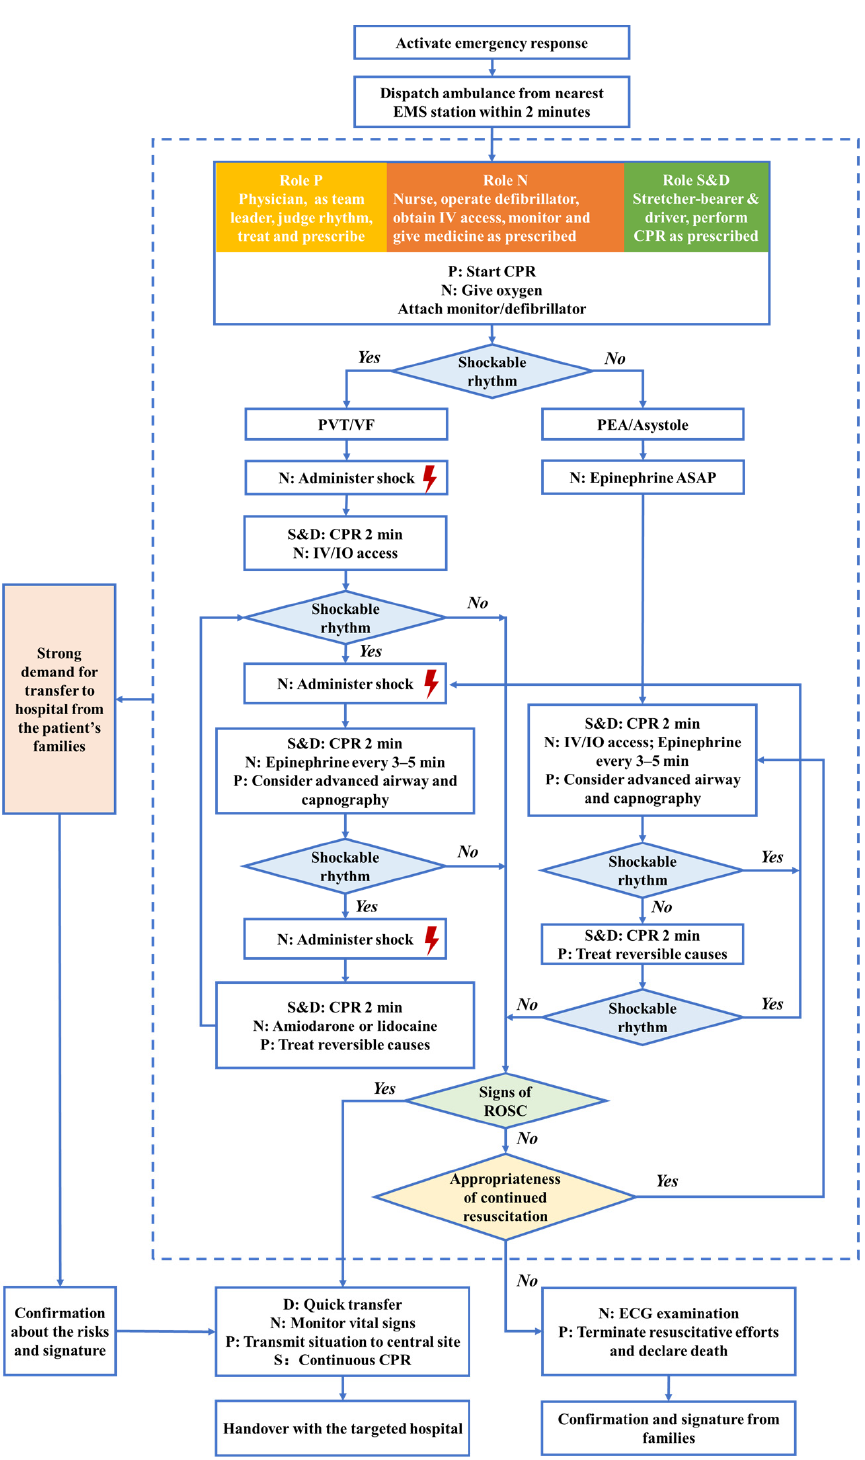
Figure 1. The standardized ambulance treatment protocol for OHCA patients. EMS, emergency medical services; OHCA, out-of-hospital cardiac arrest; CPR, cardiopulmonary resuscitation; PVT, pulseless ventricular tachycardia; VF, ventricular fibrillation; PEA, pulseless electrical activity; IV, intravenous; IO, intraosseous; ROSC, return of spontaneous circulation; ECG, electrocardiograph.